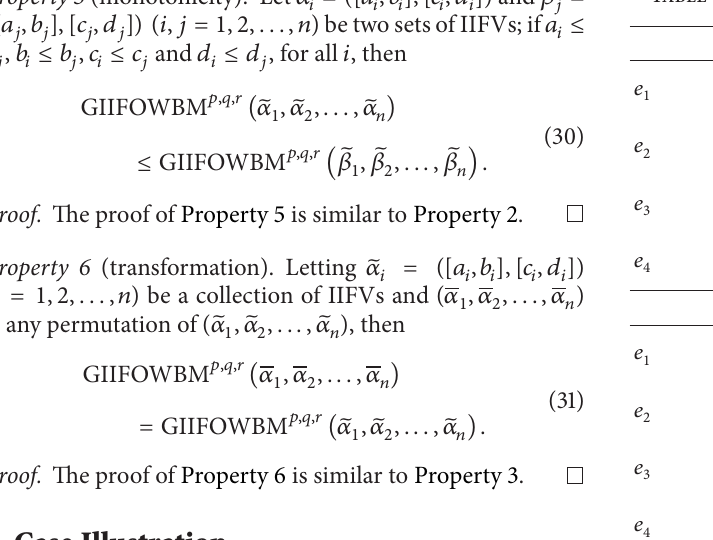
Table 1: Interval-valued intuitionistic fuzzy decision matrix 𝑅